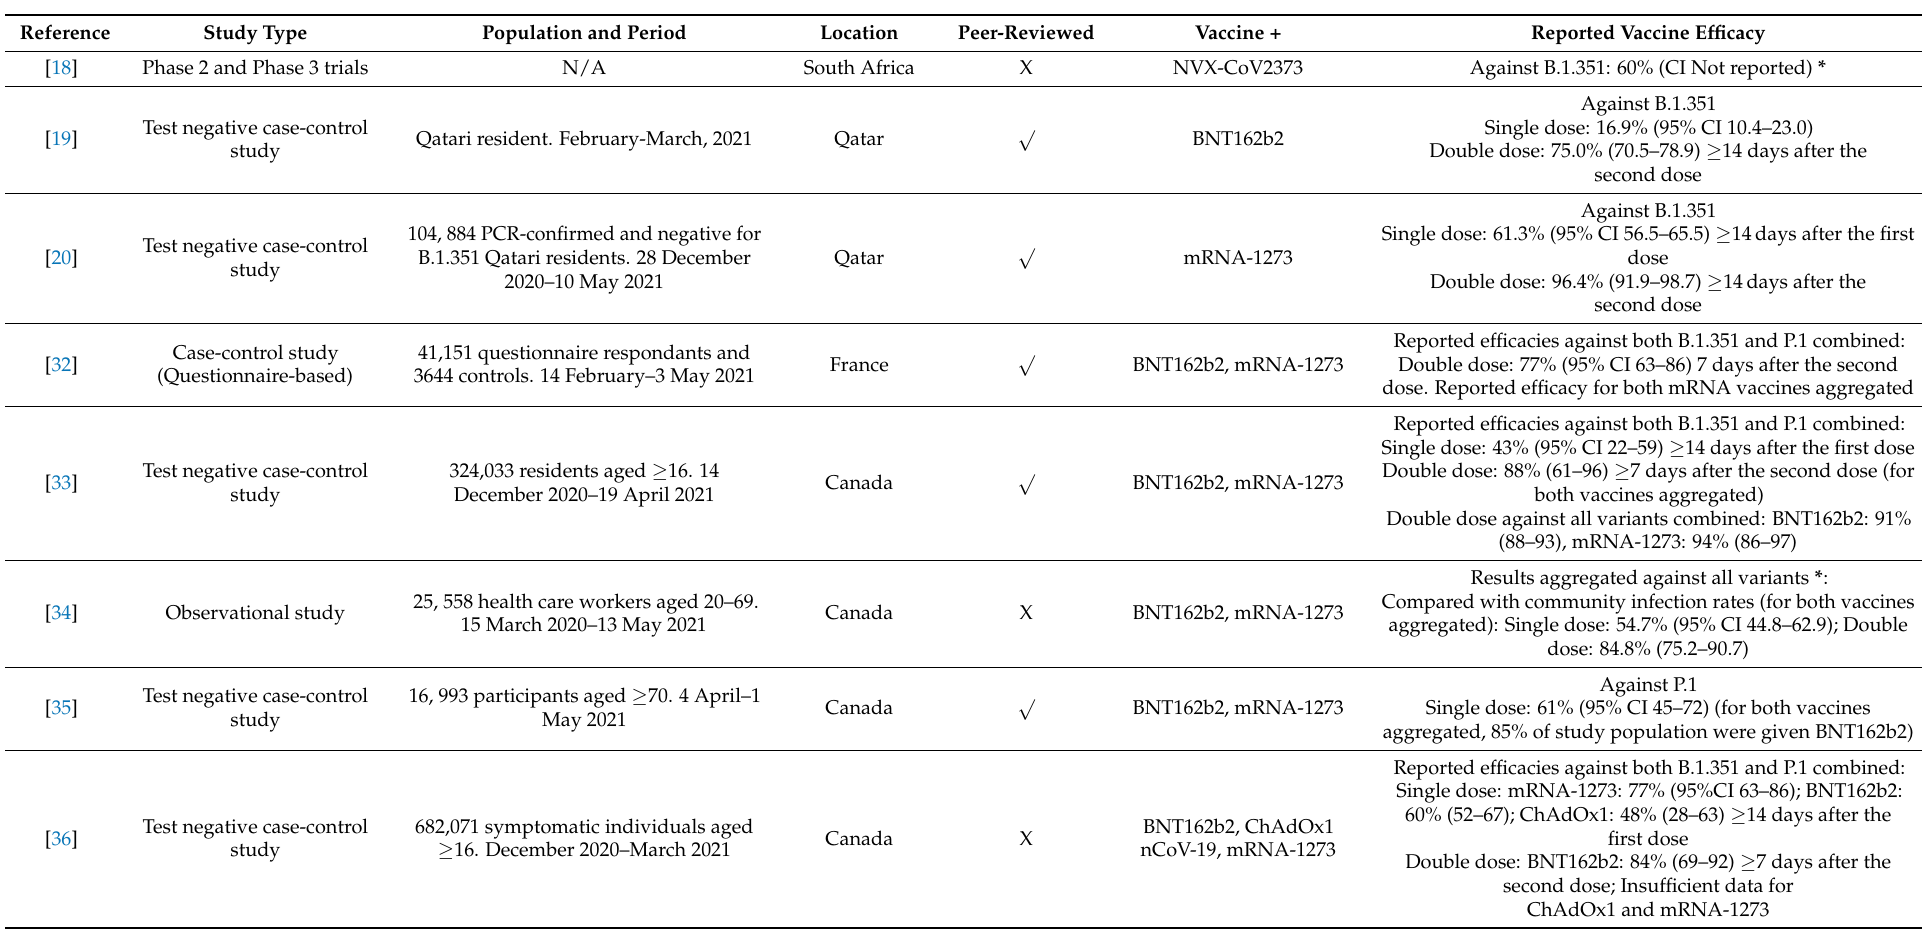
Table 3. Vaccine Effectiveness against Beta (B.1.351) and Gamma (P.1)